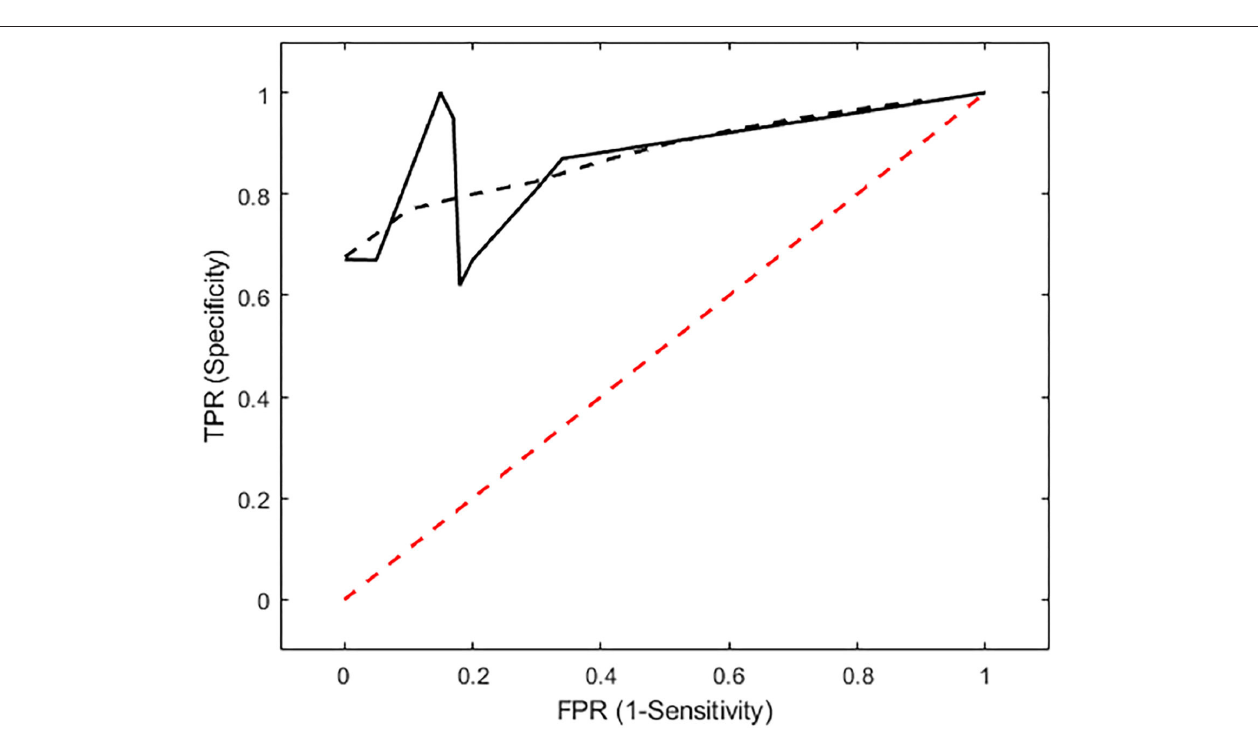
Frontiers in Veterinary Science |